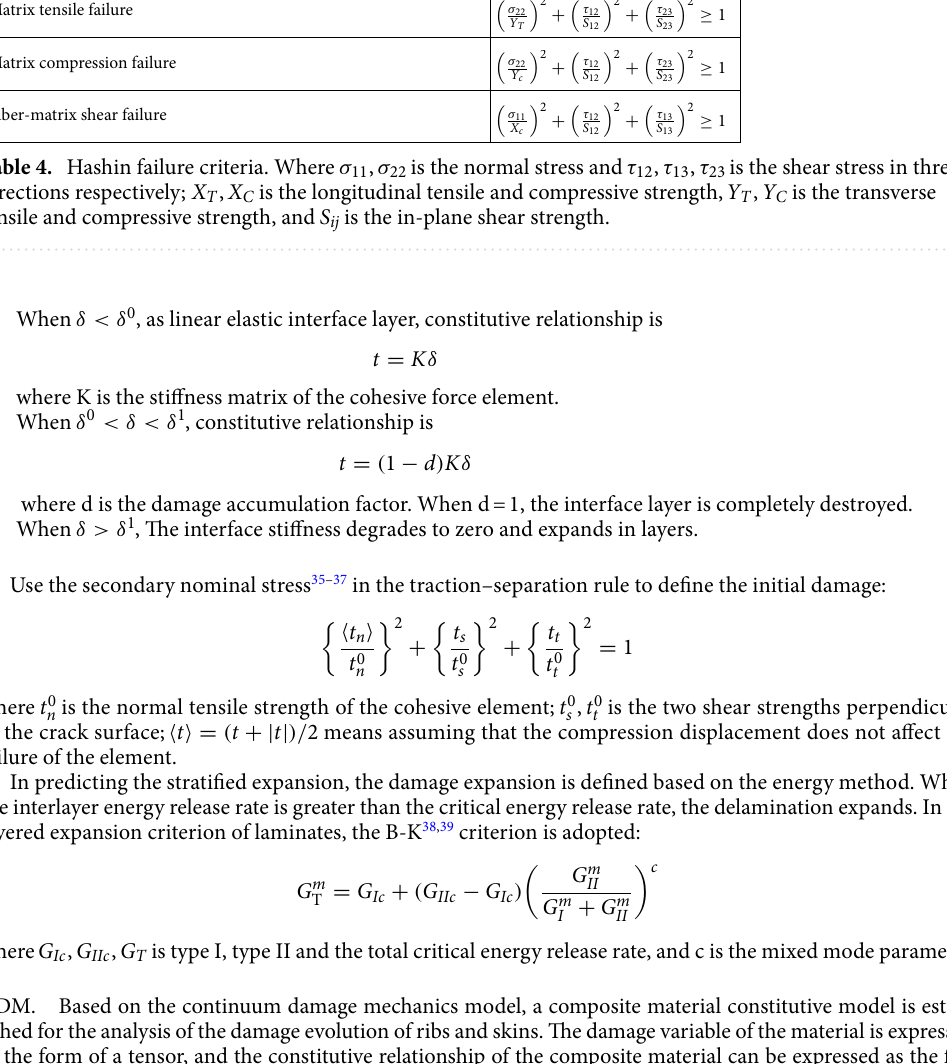
Finite element model. ABAQUS 6.14 software is adopted to establish the three-dimensional finite element model of T-stiffened panels, as shown in Fig. 4. The mechanical performance parameters of the cohesive layer are shown in Table 5. The structure consists of ply 1, ply 2, ply 3, and fillers. A layer of the cohesive unit is established on the contact surface of Ply 1 and Ply 2, 3 and filler to simulate bonding, and the filler is in cohesive contact with Ply 2 and 3. For the T-type model with damage, delete the cohesive element at the corresponding position of the defects. In the finite element analysis, both ends of the bottom of the specimen (yellow part in Fig. 4) were fixed with six degrees of freedom. Displacement load was applied on the top of the rib (red part in Fig. 4) and the direction was parallel to the bottom surface and the plane of the rib (red arrow in Fig. 4). The finite element boundary conditions of lateral bending and shearing are consistent with the experimental boundary